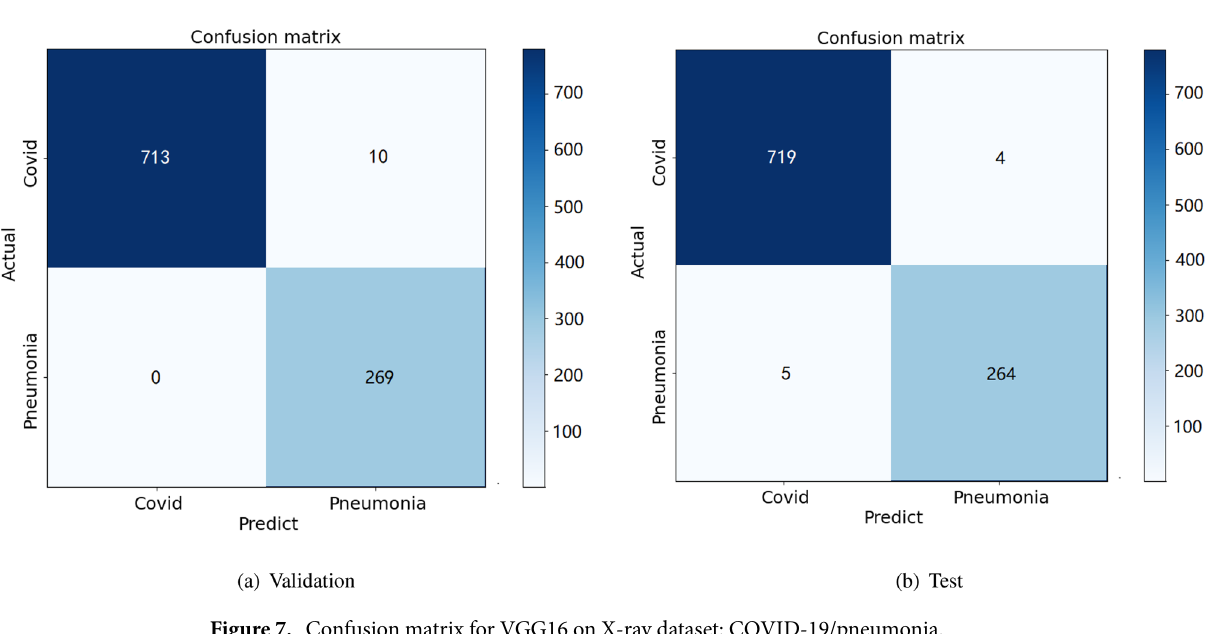
Figure 7. Confusion matrix for VGG16 on X-ray dataset: COVID-19/pneumonia.